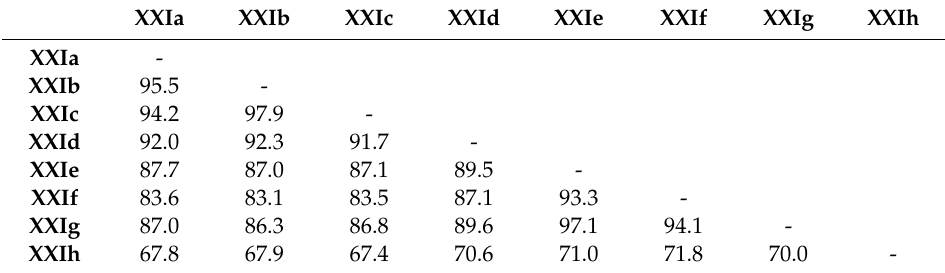
Table 2. Nucleotide sequence similarity among Cryptosporidium ryanae subtype families at the gp60 locus. XXIa